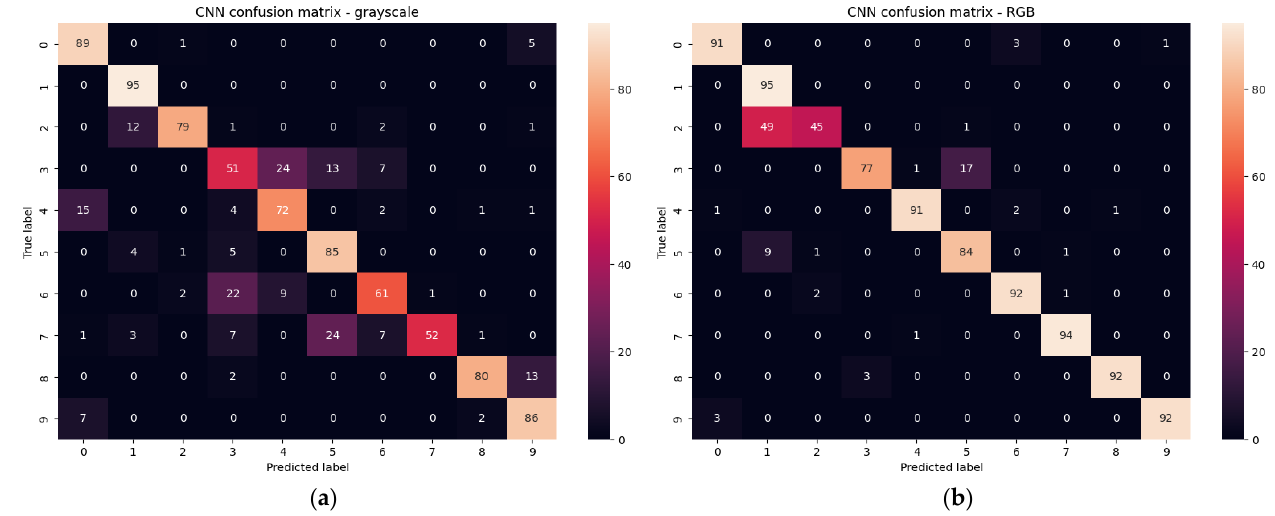
Figure 11. Confusion matrixes for test set of grayscale ( a ) and RGB ( b ) images. Analyzing the results for grayscale images, significant errors in the classification of gestures Victoria(3), Rock(6), Stop(7) are characteristic, reaching even 46%. Gesture combinations that have been particularly confused are Rabbit(2) with Palm(1), Victoria(3) with One(4) and Four(5), One(4) with Fist(0), Rock(6) with Victoria(3), Stop(7) with Four(5) and Loser(8) with Thumbleft(9). The best results were obtained for the Fist(0), Palm(1), Thumbleft(9) gestures, which reached a maximum number of errors of 9.47% for the Thumbleft(9) gesture, and the Palm(1) gesture was recognized without errors.